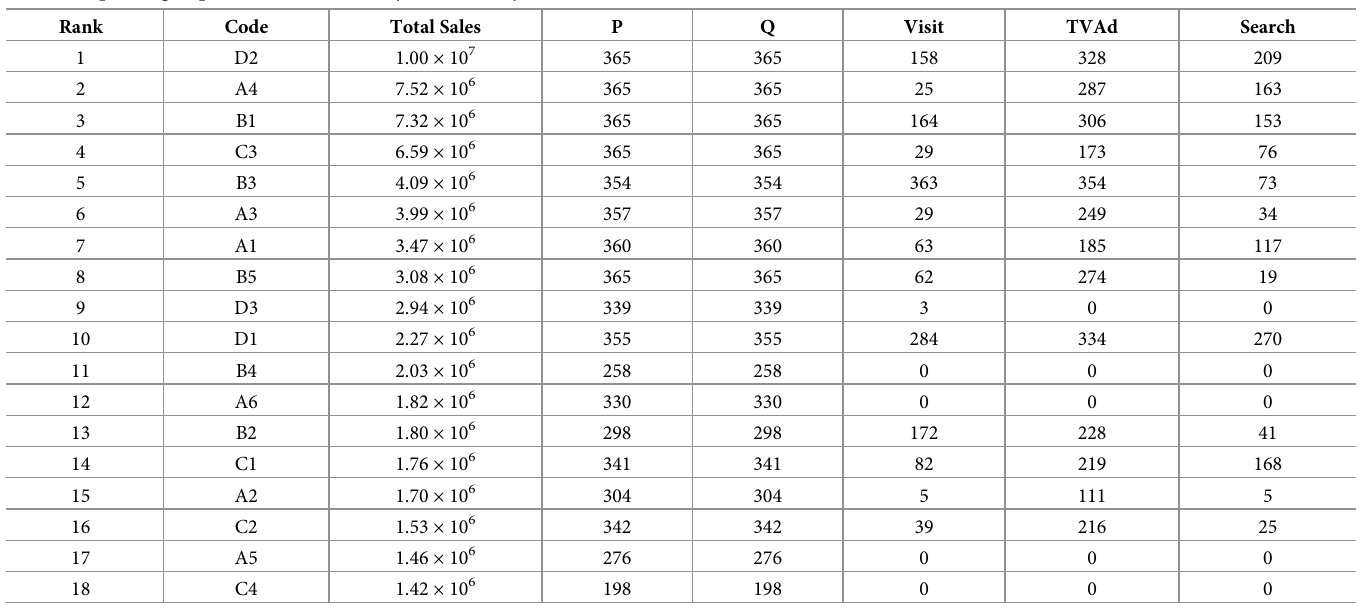
Table 2. Top-selling 18 products and availability of data in days.